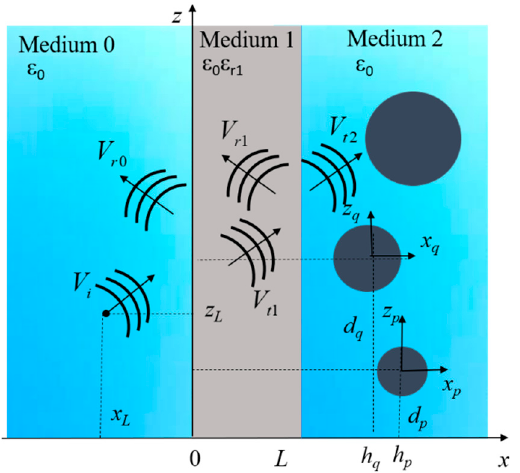
Figure 1. Geometry of the scattering problem. The incident field and the relevant reflected and transmitted fields in the absence of the targets are also highlighted.